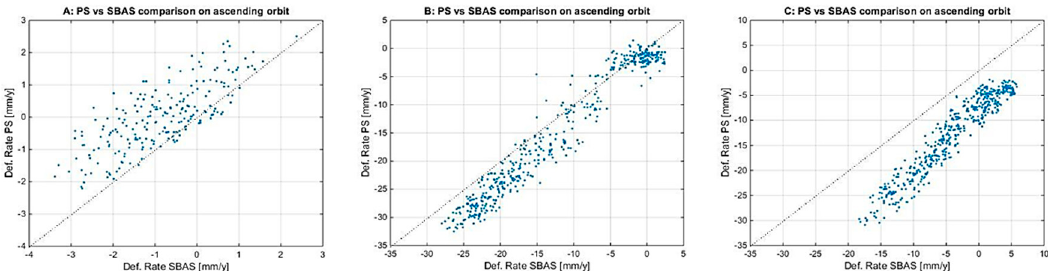
Figure 6. LOS ground velocity of the S1 ascending stack: the SBAS vs. PS cross-comparison analysis for the A, B and C selected sites of Figure 4.